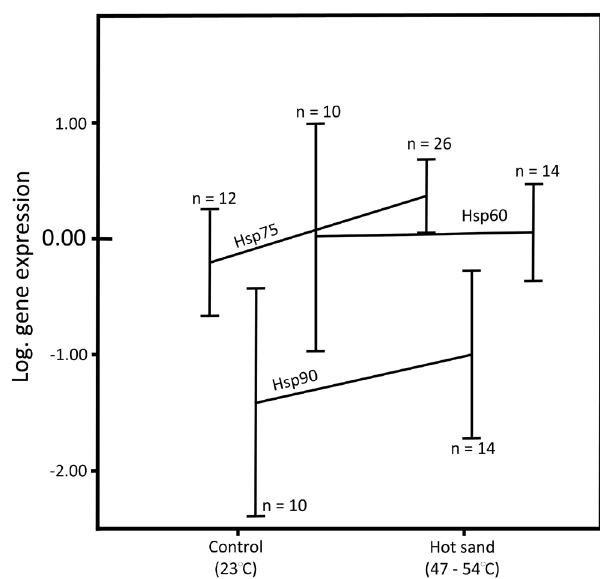
Fig 1 . Field experiment – expression of Hsp60, Hsp90 and Hsp75 in F . cinerea workers during foraging in field conditions. Mean log. value of gene expression and 95% confidence interval (Cl) error bars.